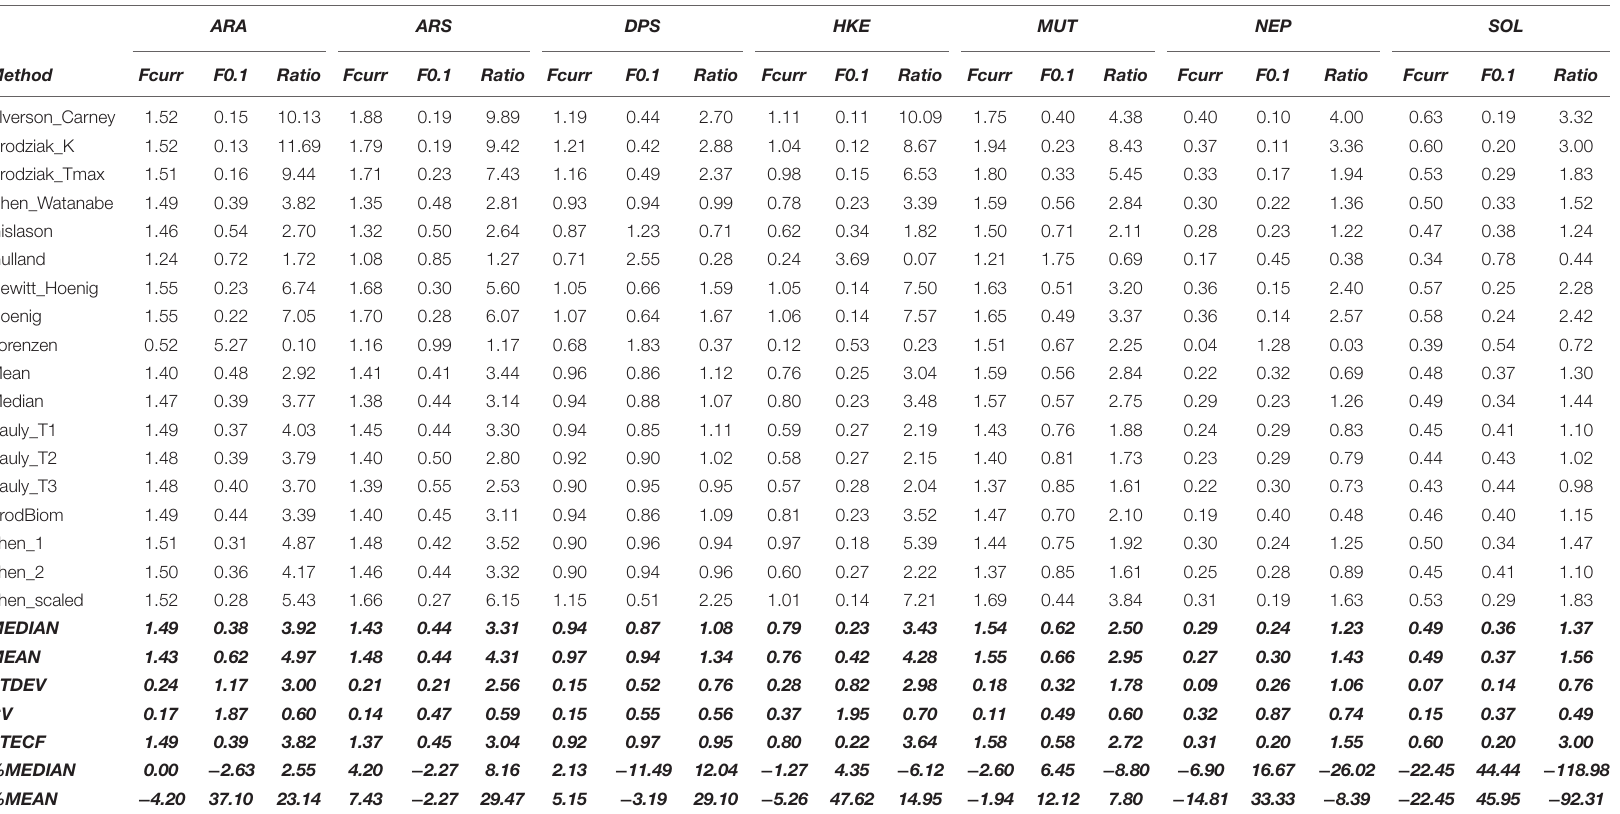
TABLE 3 | Current level of fishing mortality (F curr ), biological reference level (F 0 . 1 ), and the ratio (F curr /F 0 . 1 ) for the seven